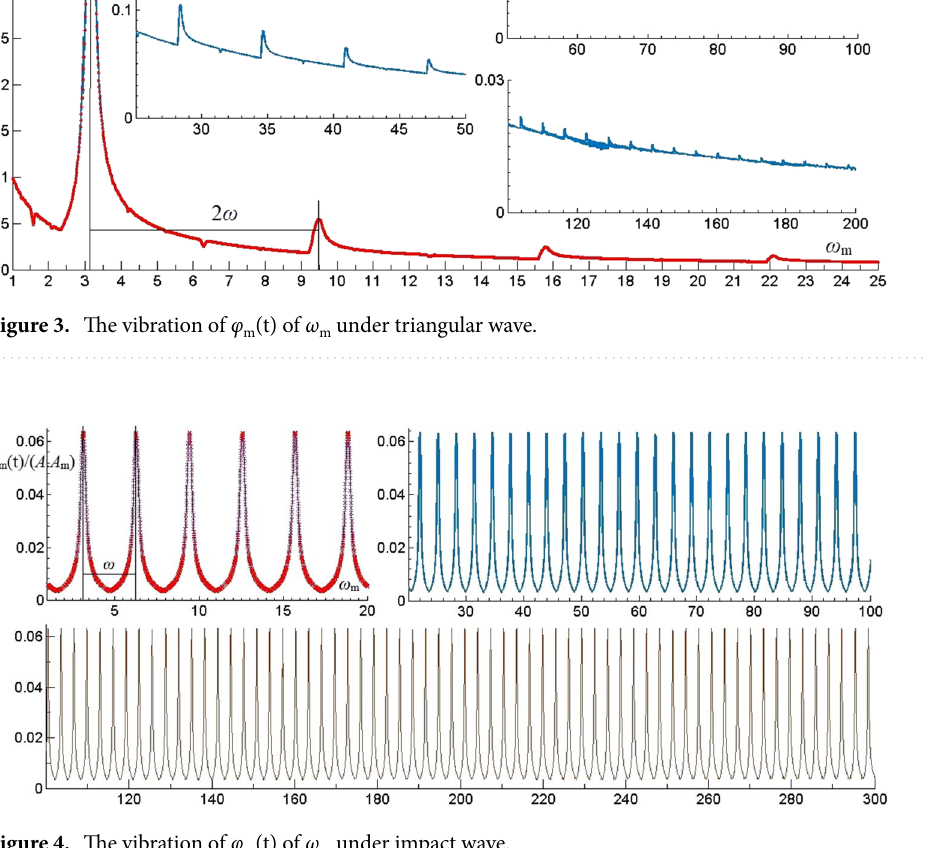
Figure 4. The vibration of φ m (t) of ω m under impact